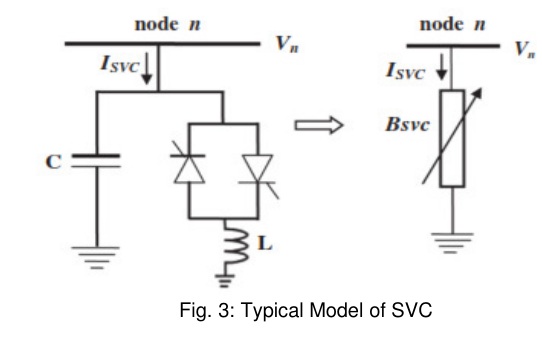
Fig. 3: Typical Model of